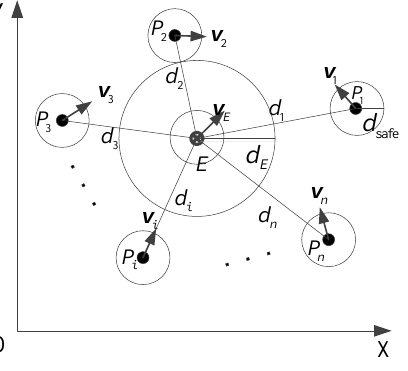
Figure 1. The schematic diagram of the multi-robot pursuit task. During the pursuit process, the movement of each pursuit robot is shown in Figure 2. Each robot moves at the maximum speed V (the magnitude of the velocity), and the P